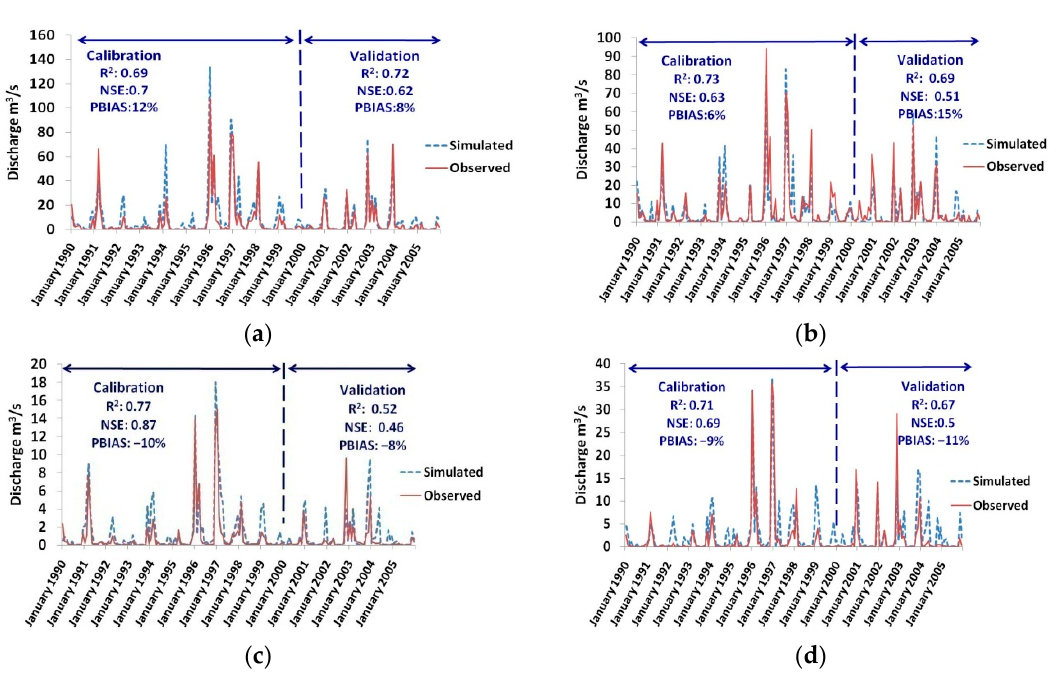
Figure 4. Simulated and observed monthly discharges during calibration and validation at the